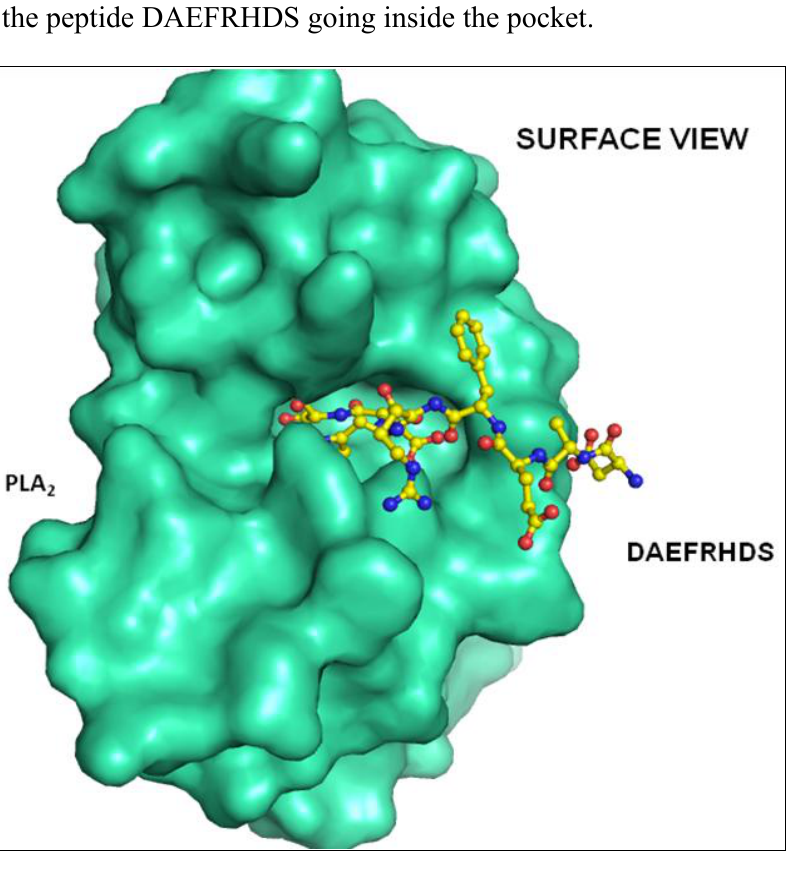
Table 3. Hydrogen bonds between PLA